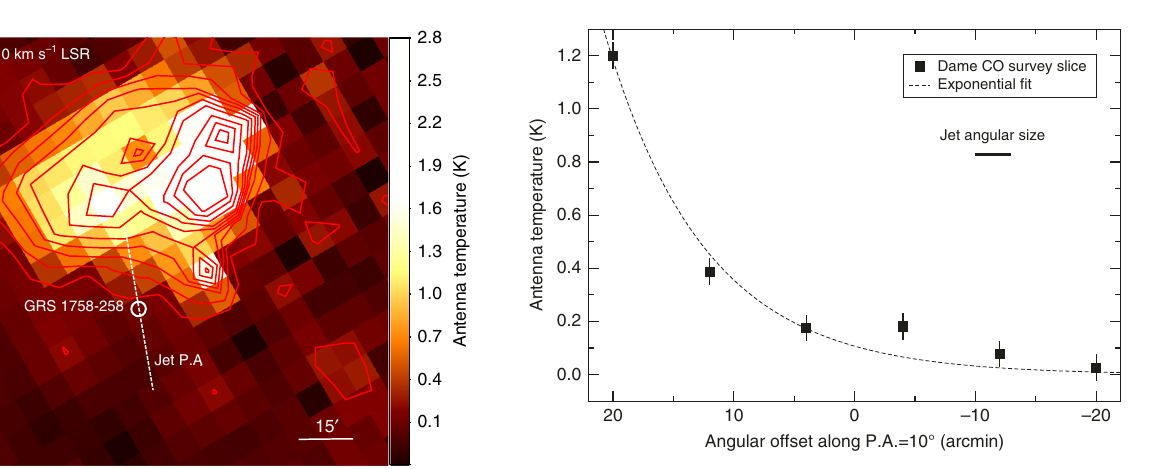
Fig. 3 Cloud of CO along the GRS 1758-258 line of sight. This map has been created from the Dame et al. survey of CO emission in the Galactic Plane 37 . The cloud is outlined with red contours and its emission peaks at a radial velocity of 210 km s − 1 with respect to the local standard of rest (LSR), corresponding to a kinematic distance of 8.5 kpc. The position of the microquasar is marked with a white circle, and the dashed line is coincident with the position angle of the jets. The horizontal bar (15 arcmin long) gives the angular scale. North is up, and east is left. The brightness scale corresponds to the antenna temperature of CO emission in Kelvin